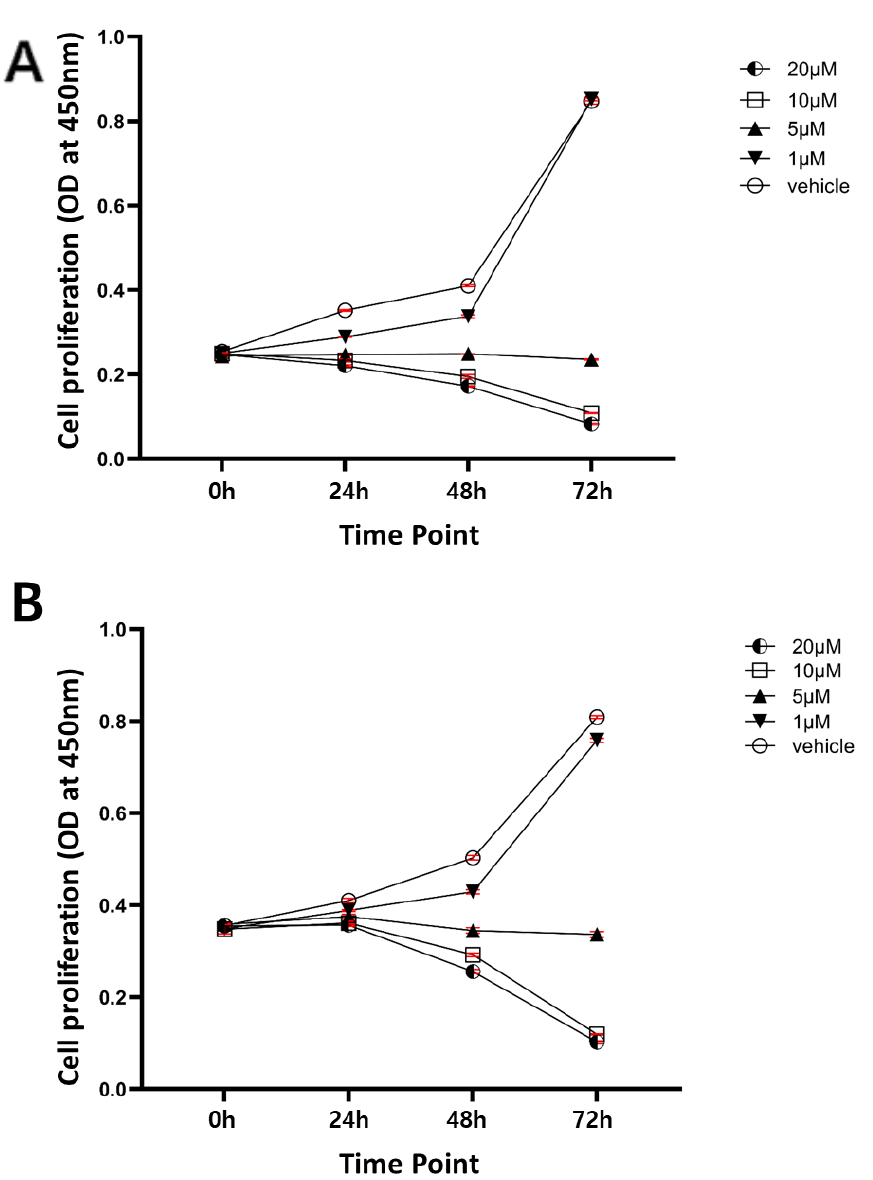
Figure 2. Vismodegib inhibits proliferation of CCC cells. The numbers of live cells were estimated using an MTT-based assay kit at the indicated time points after treating CCC cells with vismodegib at 0, 1, 5, 10, and 20 μM. ( A ) SNU-1079; ( B ) SNU-245. Data are presented as the mean ± standard error of mean (SEM).